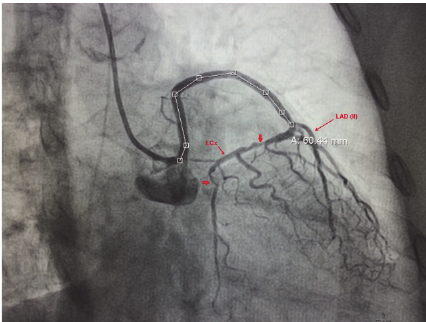
Figure 1: LMCA arising from right sinus revealing type II LAD and critical stenosis in LCx in AP cranial view.